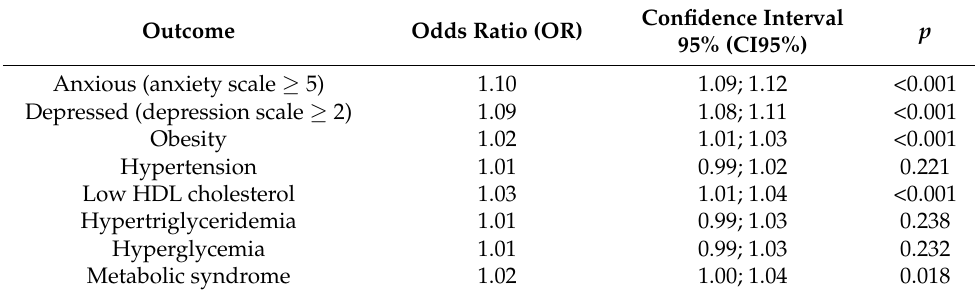
Confidence Interval p 95% (CI95%)